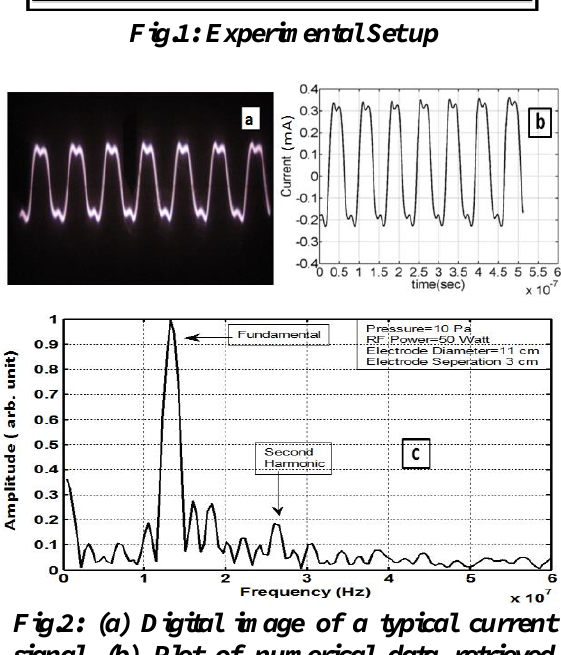
Fig.2: (a) Digital image of a typical current signal. (b) Plot of numerical data retrieved from picture in (a). (c) Frequency spectral analysis of the data in